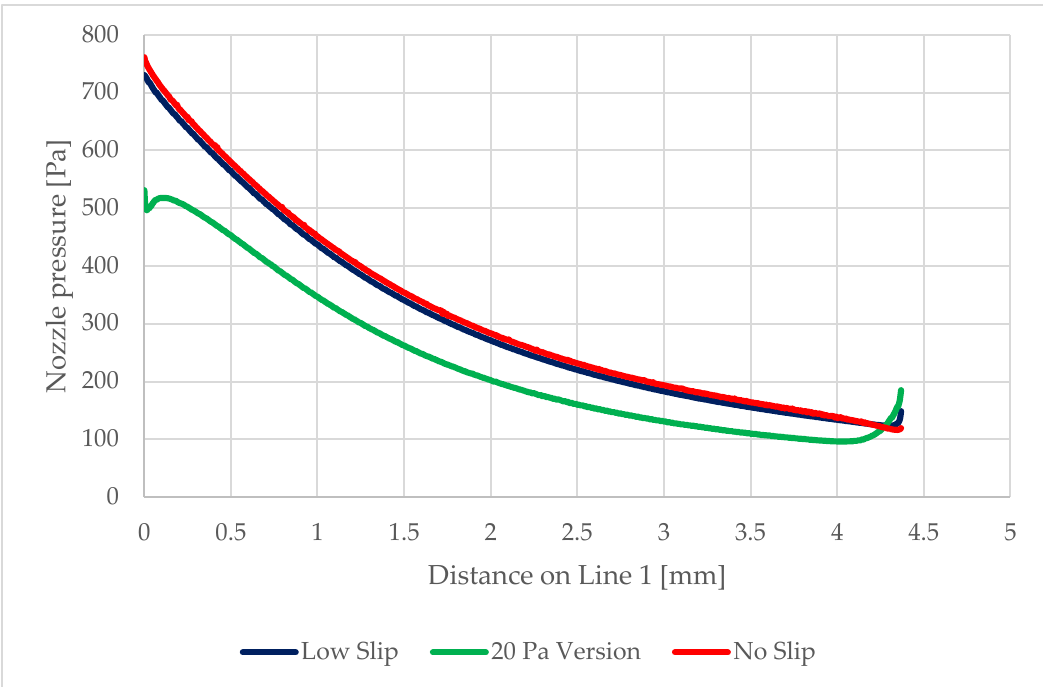
Figure 27. Static pressure distribution on the nozzle wall in the experimental chamber.